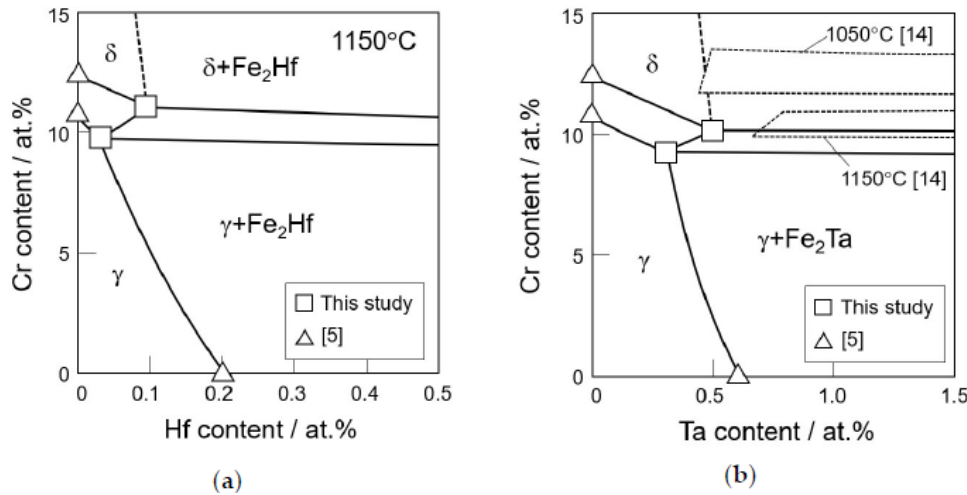
Figure 4. Isothermal sections of phase diagram in Fe-rich portion in the Fe-Cr-M (M: Hf, Ta) ternary systems: ( a ) Fe-Cr-Hf, 1150 °C, ( b ) Fe-Cr-Ta, 1100 °C. Tie-triangles at 1150 °C and 1050 °C reported in [14] are included in ( b ).